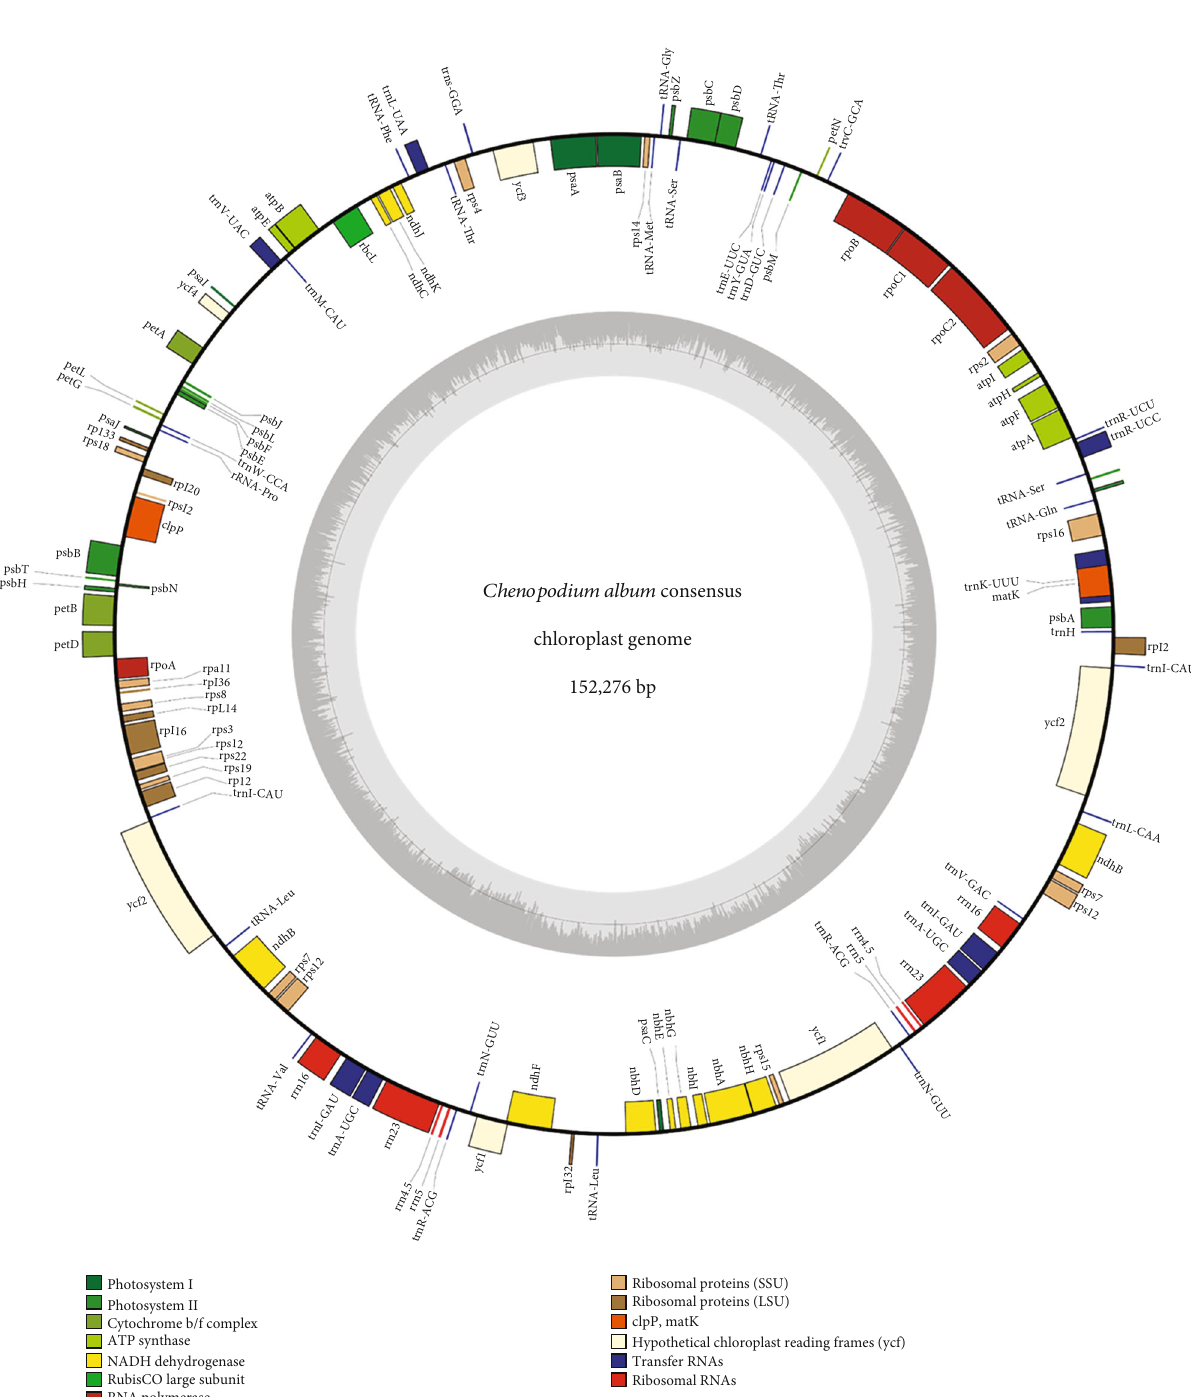
Figure 2: A circular gene map of six Chenopodium album chloroplast genomes. Genes shown outside are transcribed clockwise, and inside the circle are transcribed counterclockwise. Genes are color-coded to distinguish di ff erent functional groups. The dark grey and the light grey plots in the inner circle correspond to the GC content and AT content,